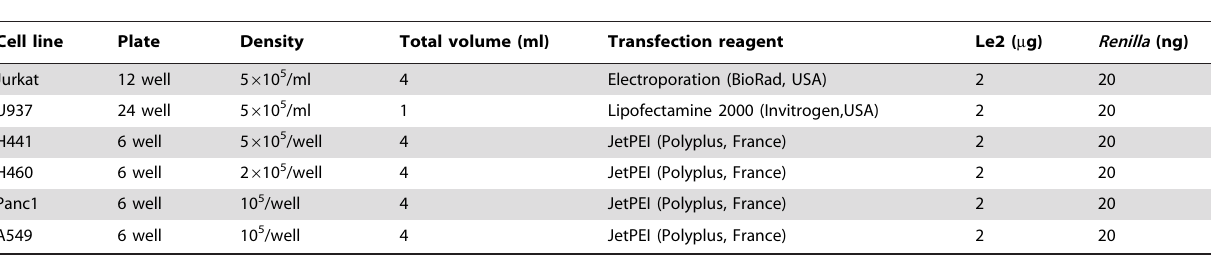
Table 2. Transfection conditions for different cell lines used in this study.